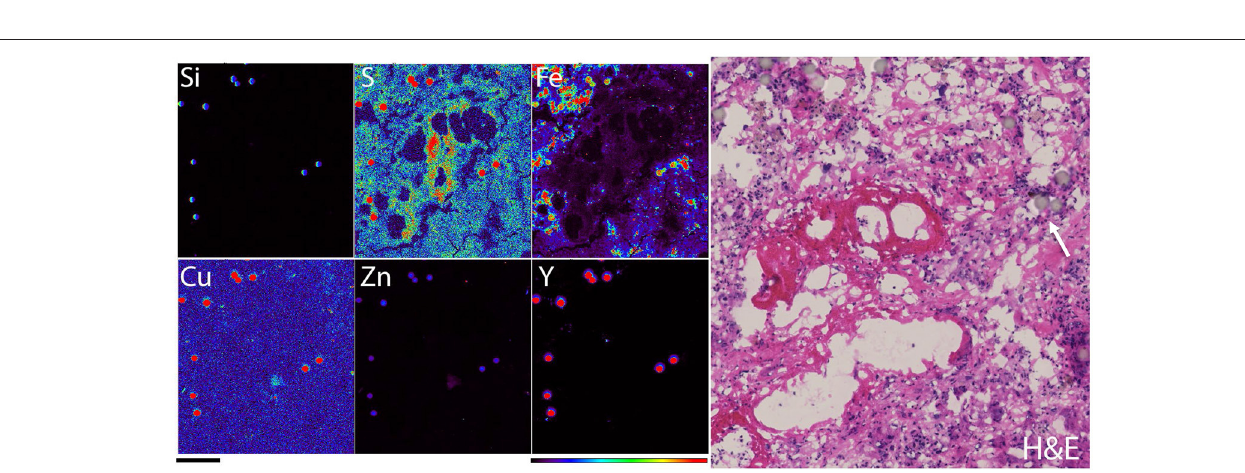
FIGURE 2 | Elemental map of a detail of rat liver tissue obtained with 300 nanometer spot size (station 2ID-E), X-ray energy 21 keV. At this x-ray energy fluorescence produced by yttrium overwhelms signals of most biological elements and the speres “appear in all elemental channels.” Elemental maps were obtained simultaneously while sample was moved by rapid raster scanning (so called: “fly scans”) through the X-ray beam. Scale bar − 200 microns, color bar indicates elemental quantity as represented by false colors, from black (no signal) to red (highest signal). Elemental signal maxima in micrograms per cm square for different elements were: 804 for Si, 14.5 for S, 0.499 for Cu, 37.1 for Fe, 7.79 for Zn and 774 for Y. Hematoxylin and eosin staining of the same region in one of the adjacent tissue sections is shown in the right hand panel; white arrow points to a TheraSphere. Please note that the same areas were scanned at lower magnification in Figure 1 , as